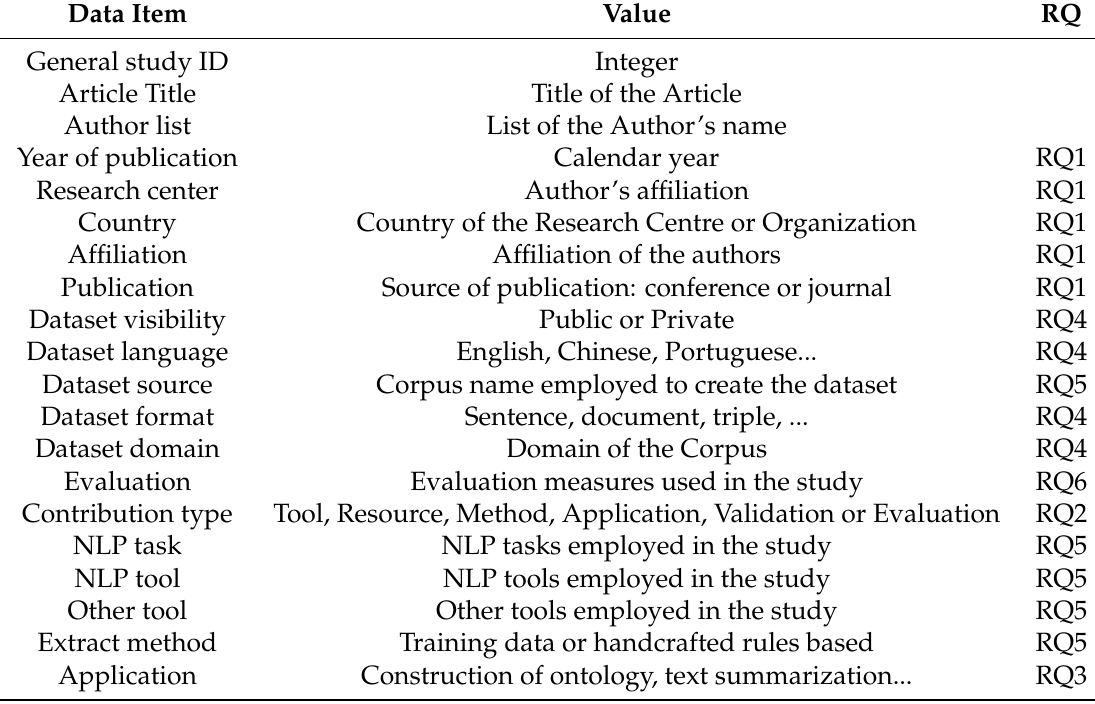
Table 2. Data extraction form manipulated by our SMS, adapted from